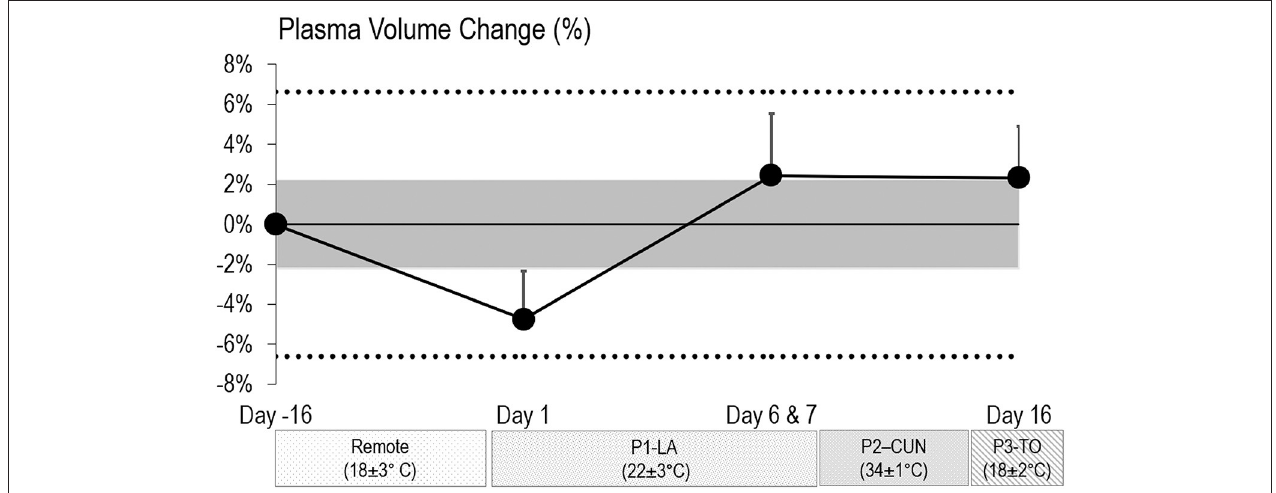
FIGURE 4 | Plasma volume change from baseline testing (day − 16) to each follow-up test occasion on day 1 and day 6/7 in Los Angeles (P1—LA) and day 16 in Toronto (P3—TO). No blood draw occurred during phase 2 in Cancun (P2—CUN). The shaded area represents trivial changes, and the dash line represents the lower limit for moderate changes [ < 0.20, > 0.60, and > 1.20 of baseline between-subject standard deviation (SD)]. Bars are SDs of changes from baseline to day 6/7 and baseline to day 16. None of the changes were significant ( p >